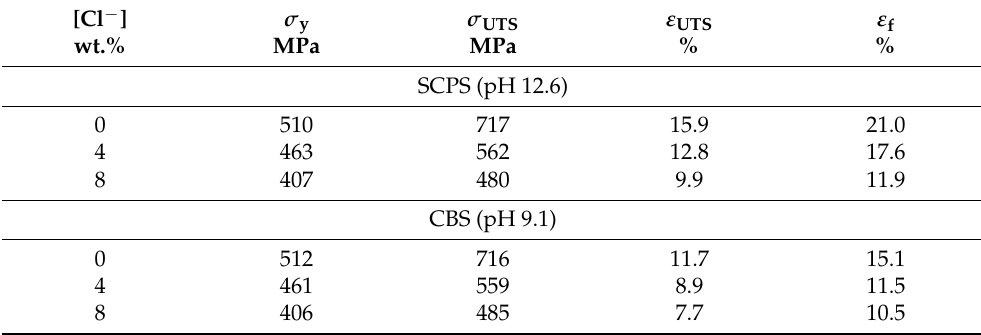
Figure 2. Stress/strain curves of UNS S32205 reinforcement as a function of the chloride content: ( a ) simulated concrete pore solution (SCPS, pH 12.6), and ( b ) carbonated solution (CBS, pH 9.1). Table 2. Mechanical properties of UNS S32205 reinforcement after slow strain rate test (SSRT) in simulated concrete pore solution (SCPS, pH 12.6), and carbonated (CBS, pH 9.1) environments at different chloride